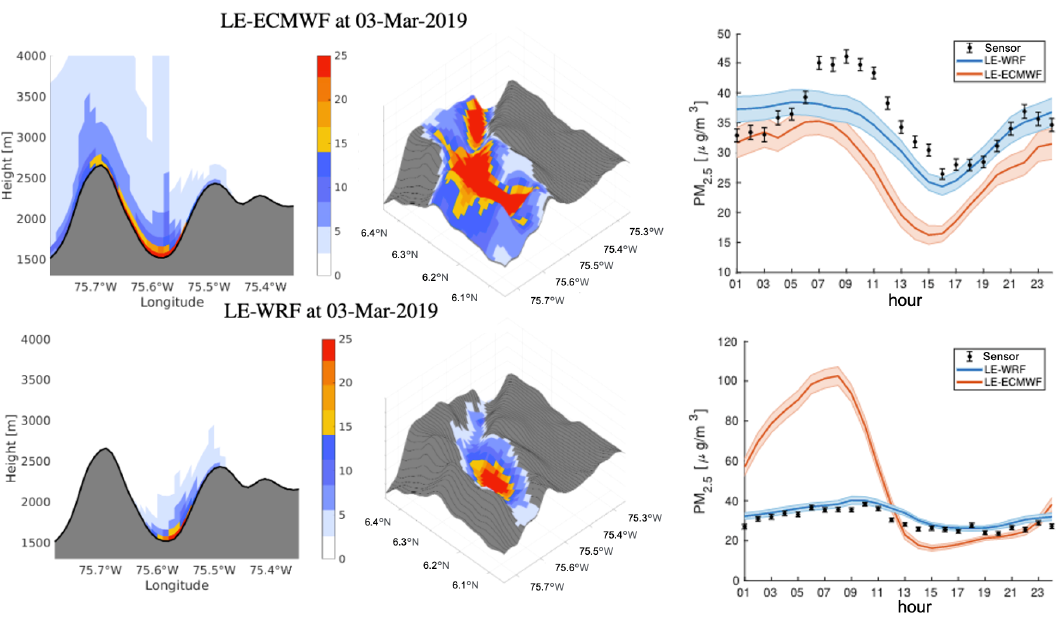
Figure 2. Transversal cut comparisons, three-dimensional snapshot of the model output over the valley and assimilated outputs of a low-cost sensor network inside the